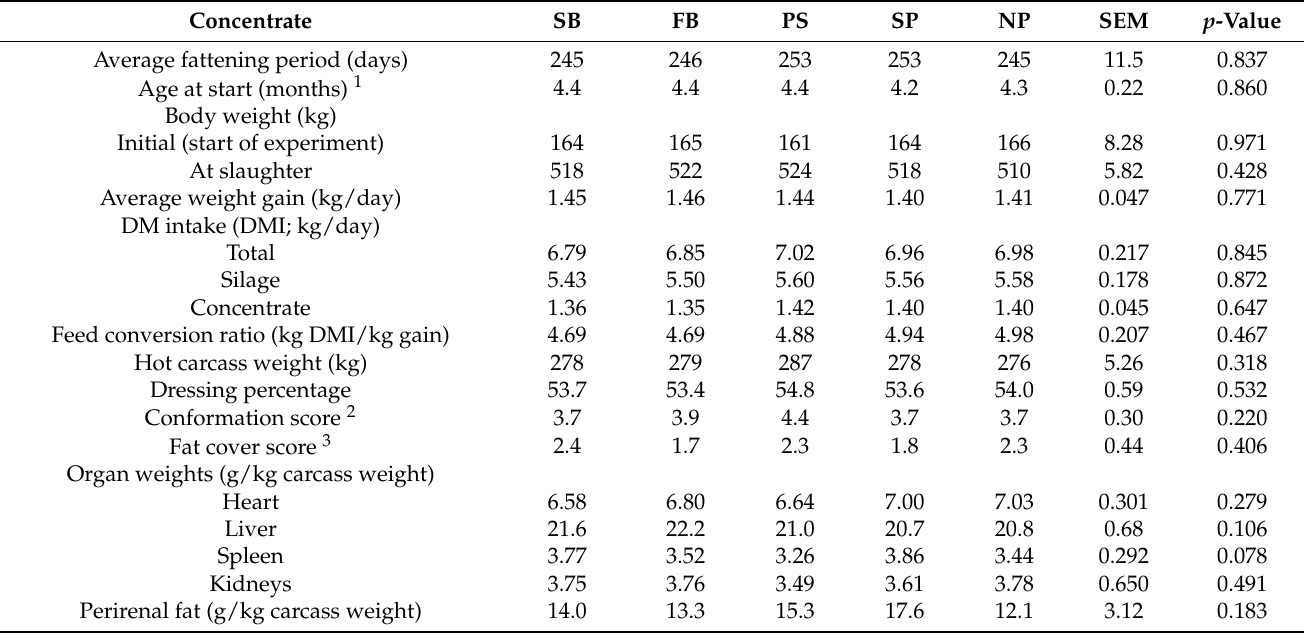
Table 4. Feed intake, growth, and slaughter performance of fattening bulls fed a grass/maize-silage based diet comple- mented with concentrates containing soybean meal (SB), faba beans (FB), pumpkin seed cake (PS), spirulina (SP), or no additional protein source (NP) ( n = 6 per